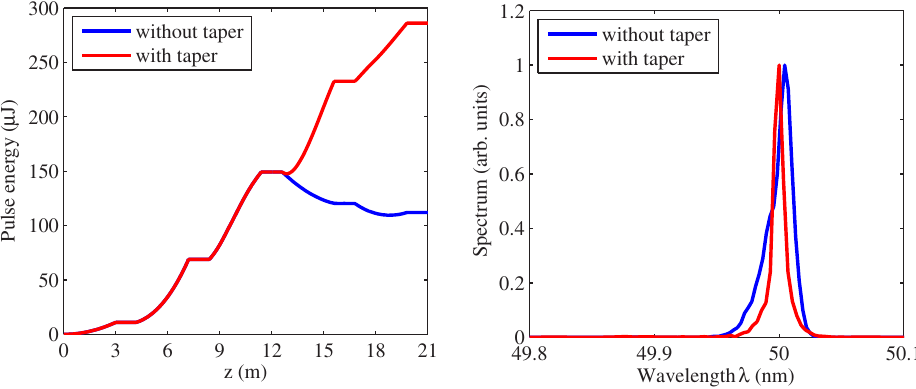
FIG. 4. Start-to-end simulation results for FEL peak power growth in the radiator undulator and the final output radiation spectrum of